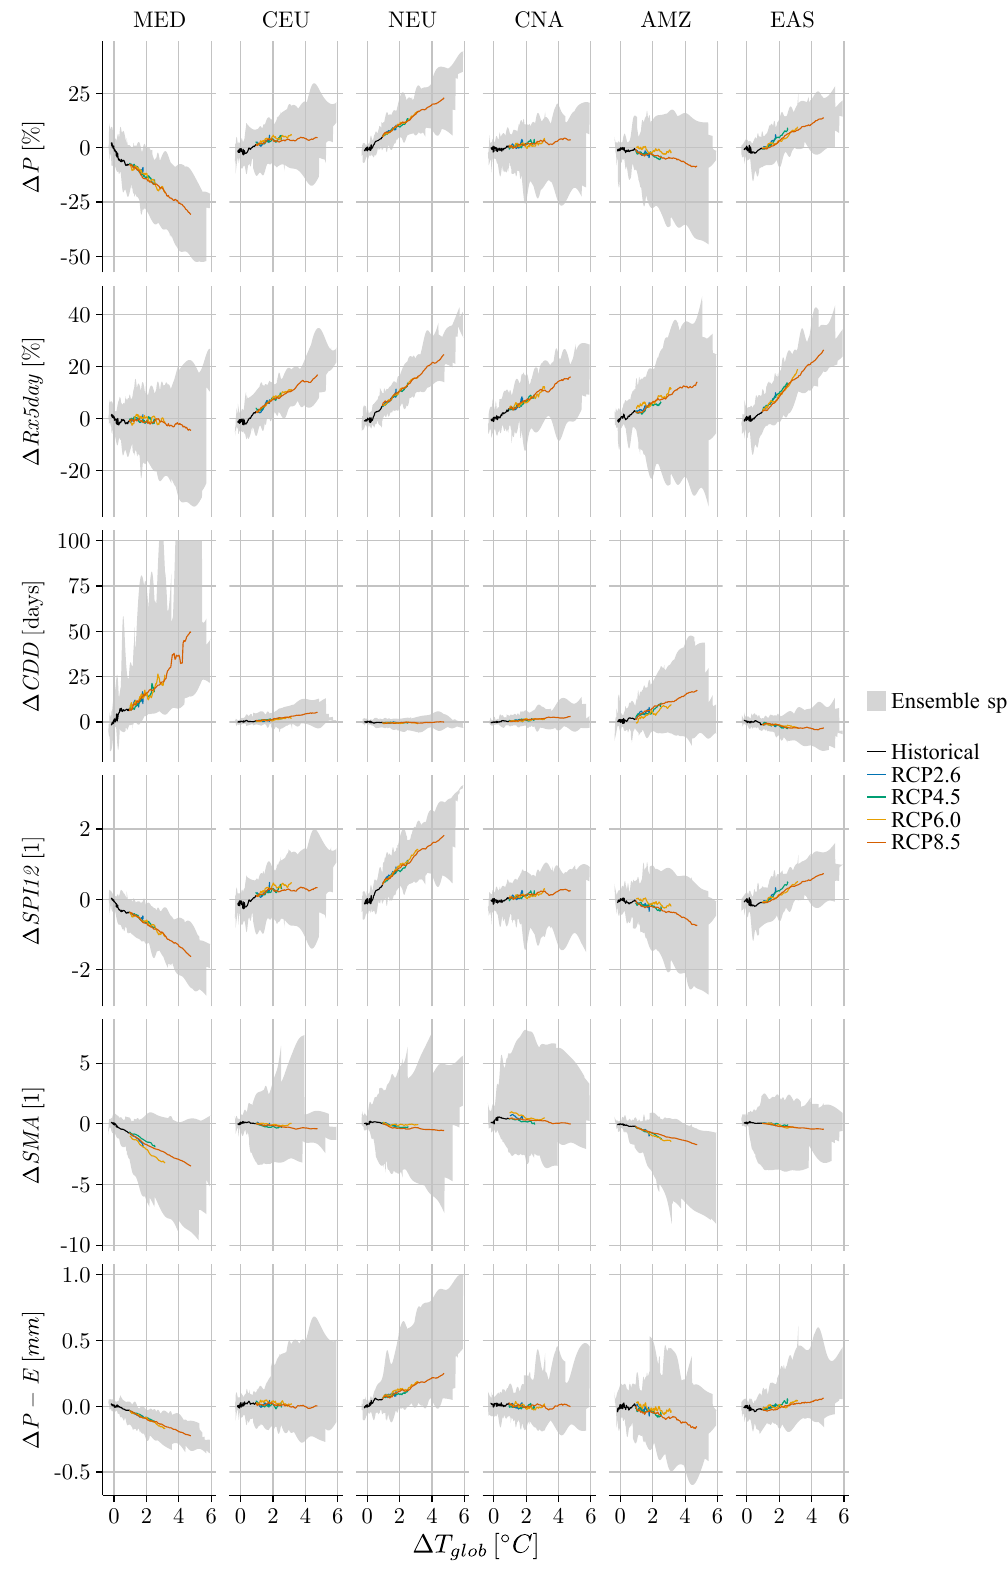
Figure 4. Like Fig. 3 but for the indices (cid:49)P , (cid:49) Rx5day, (cid:49) CDD, (cid:49) SPI12, (cid:49) SMA, and (cid:49)P − E . Values for (cid:49) CDD > 100 days were cut off for